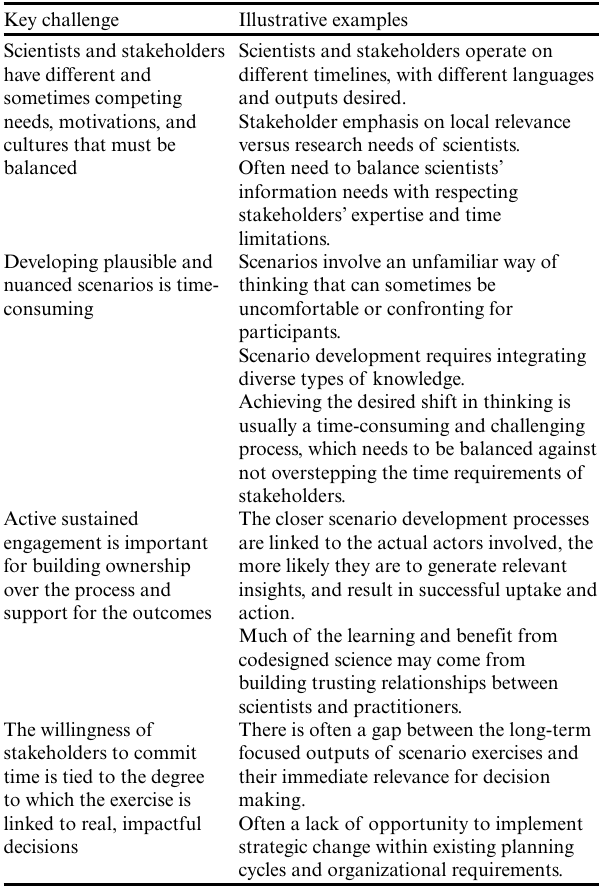
Table 2 . Challenges to implementing a successful participatory scenario development process identified during the initial codesign